Question: Give a one-sentence summary of this figure.
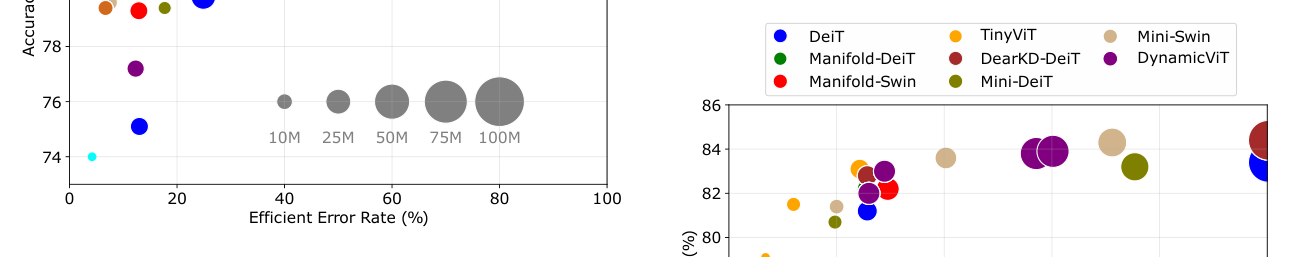
Answer: Graphical comparison of CA model Top-1 accuracies and EER values on the ImageNet-1K dataset. The area of bubbles corresponds to the number of trainable parameters (#Param). The reference #Param sizes (from 10M to 100M) are shown in gray in the bottom right corner.